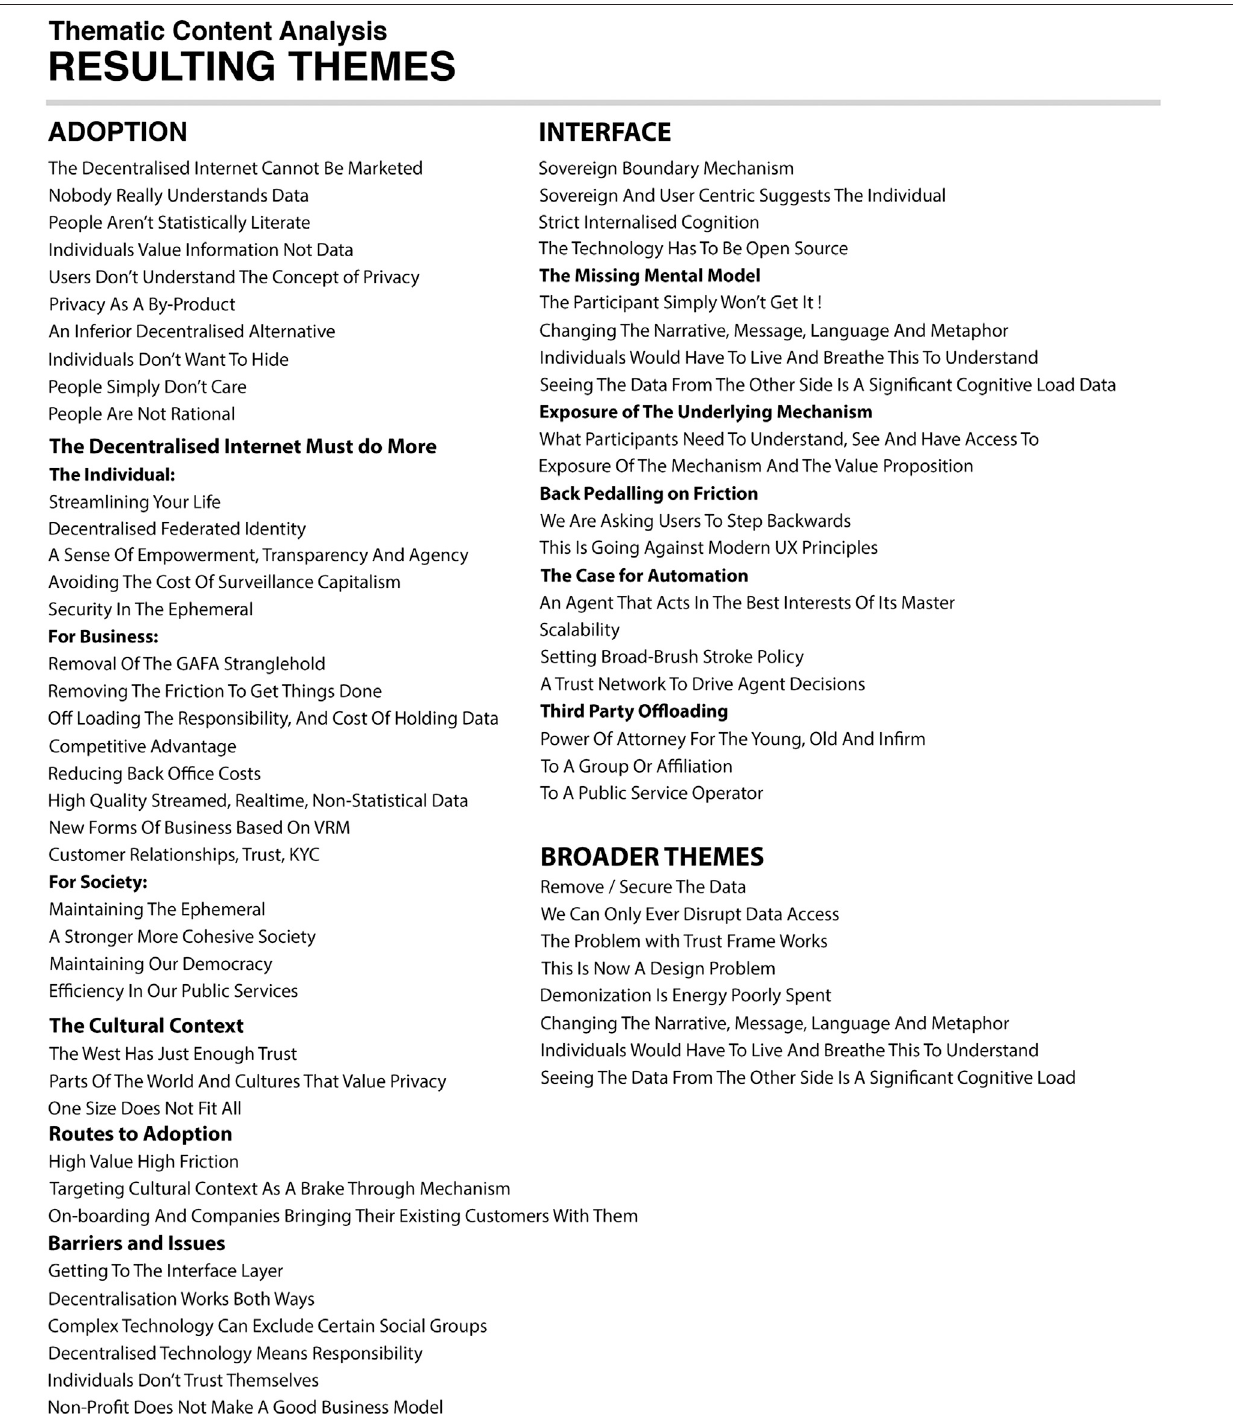
FIGURE 2 | Theme category ’ s and